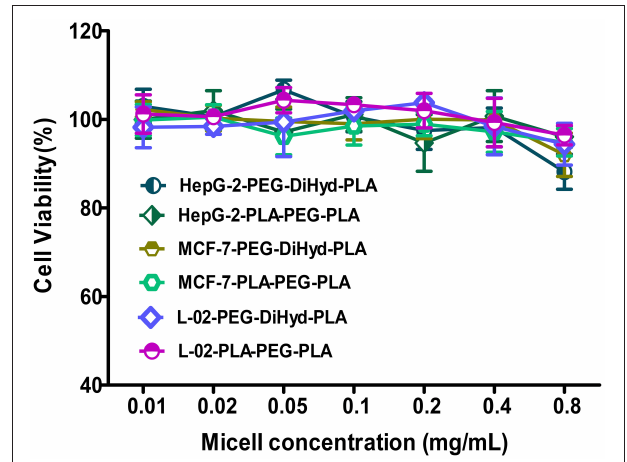
FIGURE 7 | The cytotoxicity of blank PLA-PEG-PLA-18K, PEG-DiHyd-PLA-18K micelles incubated with HepG-2, MCF-7, and L-02 cells for 48h. Error bars indicate the standard error of the mean (SEM) for ( n = 3) independent experiments.